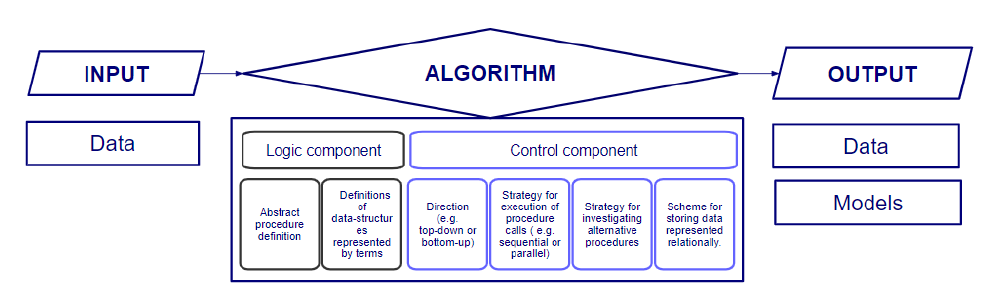
Figure 2. Decision-making process and decomposition of algorithms into their characteristics and